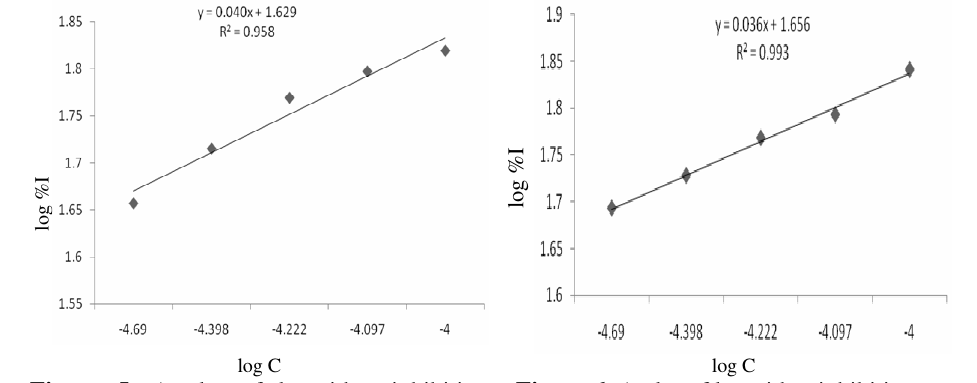
Figure 6. A plot of logarithm inhibition efficiency against logarithm of concentration for nizoral + KI